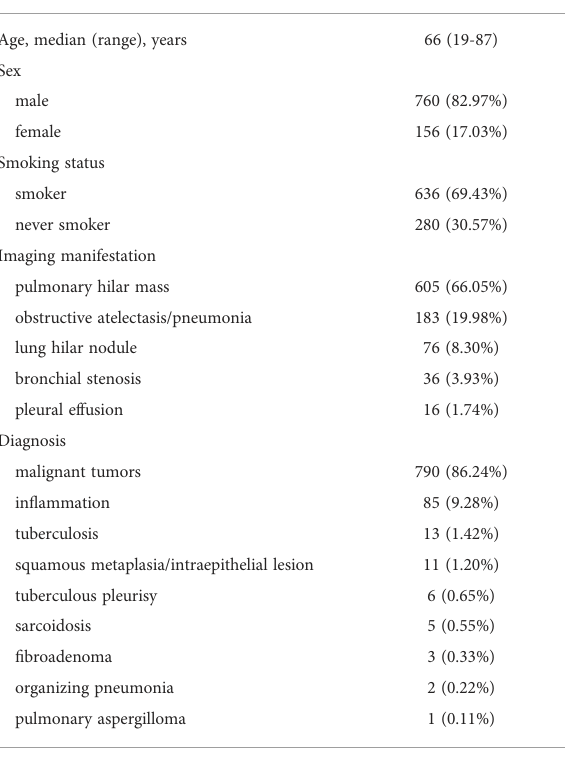
TABLE 1 Clinical data of all